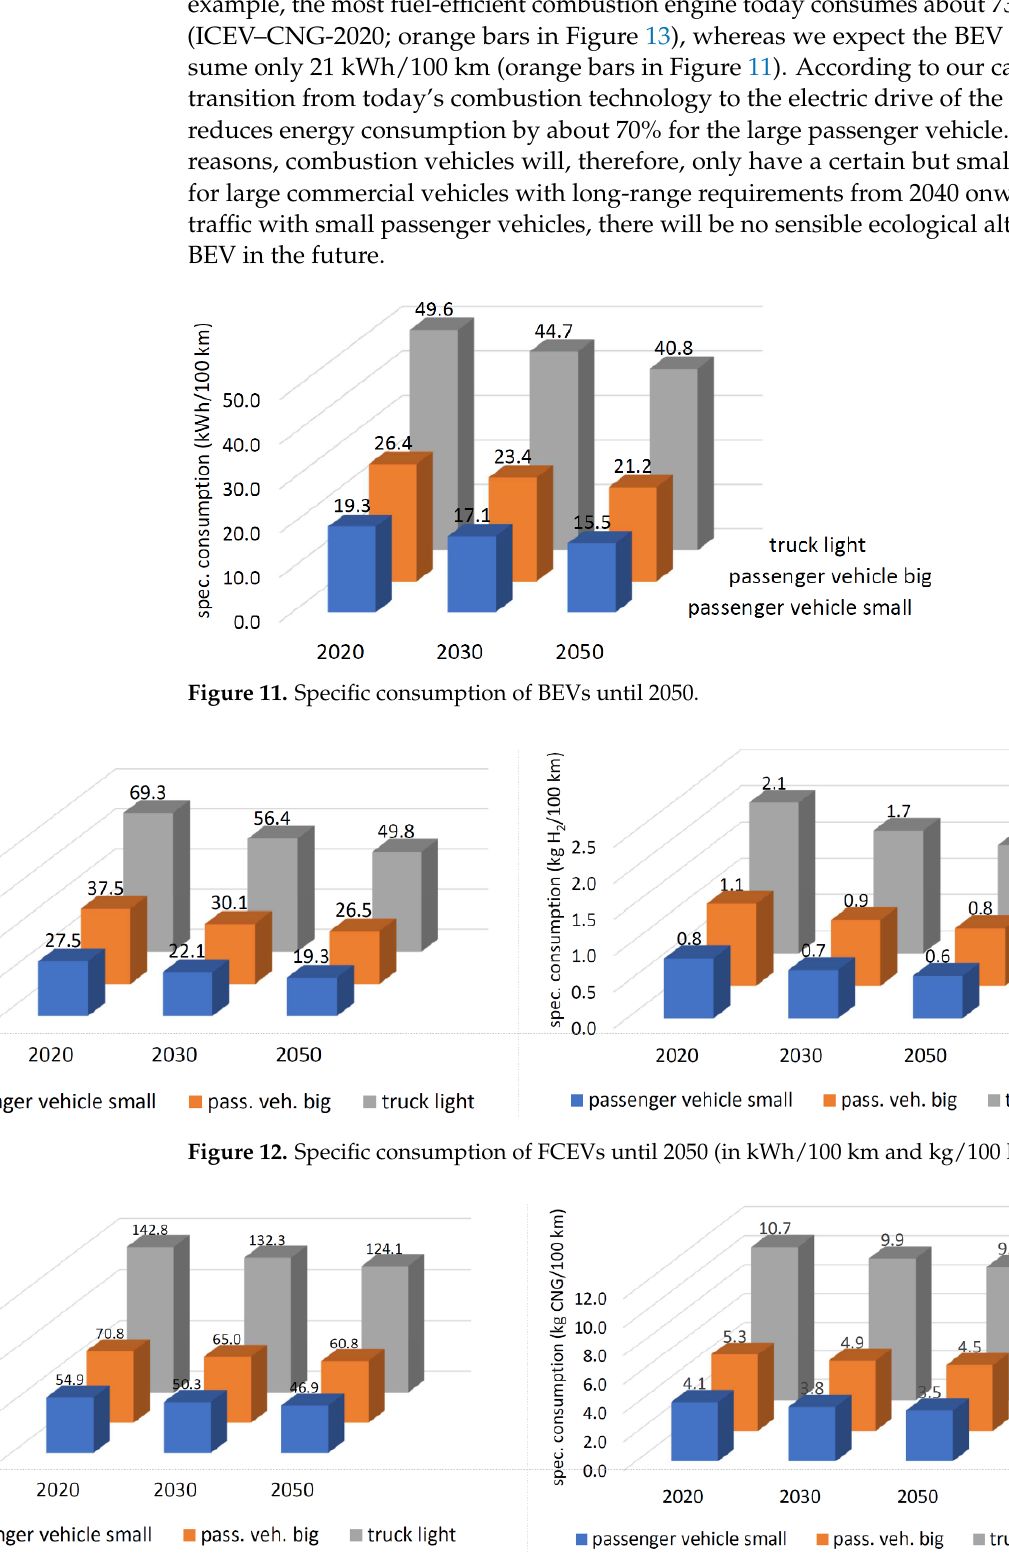
Figure 13. Specific consumption of ICEVs–CNG until 2050 (in kWh/100 km and kg/100 km).